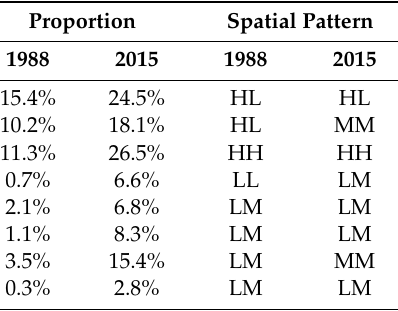
Figure 11. AIs of the bays in 1988 and 2015. ( a ) Hai Loc Bay; ( b ) Dam Ha Trung Bay; ( c ) Danang Bay;